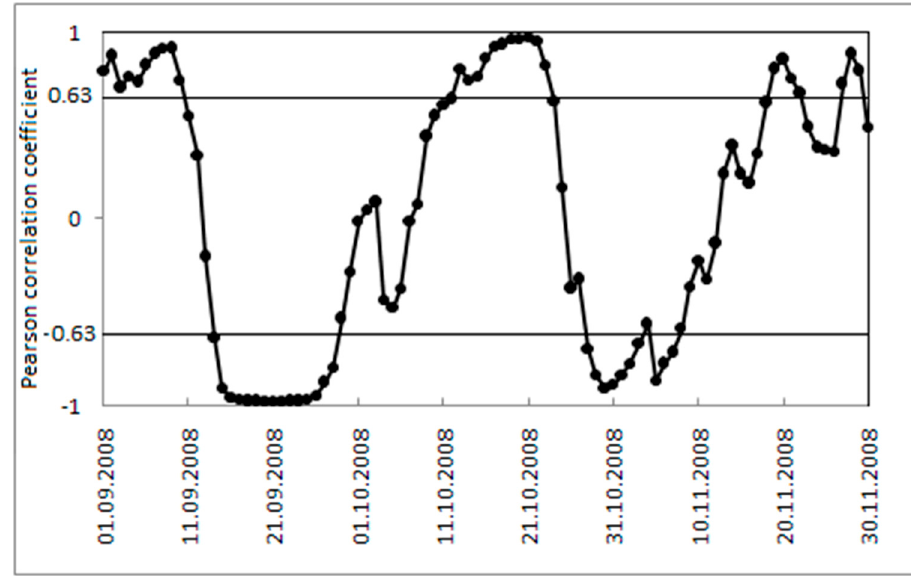
Figure 7. The Pearson correlation coefficient r between daily ATSI and 15 day running mean of daily mortality in 10-day blocks for Khabarovsk over the autumn of 2008 (1 September to 30 November). Values ˘ 0.63 indicate critical values of the Pearson correlation coefficient for 0.05 level of significance. Figure 7 shows correlation between daily ATSI and 15-day running means of daily mortality in 10-day blocks for Khabarovsk over autumn of 2008 for the period 1 September to 30 November with no lag. The critical values of the Pearson correlation coefficient r for levels of significance 0.05 and eight degrees of freedom (the sample size 10) is 0.6313. The darker data points in Figure 6 and horizontal line in Figure 7 show times during autumn with the strongest relationship with r that is higher than critical value